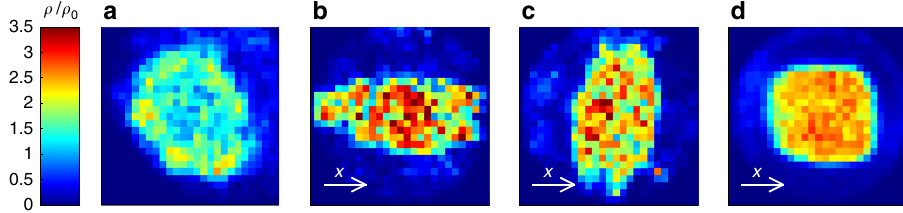
Fig. 5 Experimentally measured structural changes due to motility response variations. a ‘ Ring ’ : when the local density c exceeds a second threshold c th,2 > c v th , the swimming velocity is set to 0 again. This reduces the density in the centre of the cluster (scale bar 65 dependent term f ( Θ ) = cos 4 ( Θ ). c Changing f ( Θ ) to f ( Θ ) = sin 4 ( Θ ) leads to rotation of the ellipse by 90°. d ‘ Square ’ : doubling the frequency of the angle- dependent term to f ( Θ ) = cos 4 (2 ⋅ Θ ) leads to a square-shaped cluster. In ( b – d ) the arrow shows the direction of the x